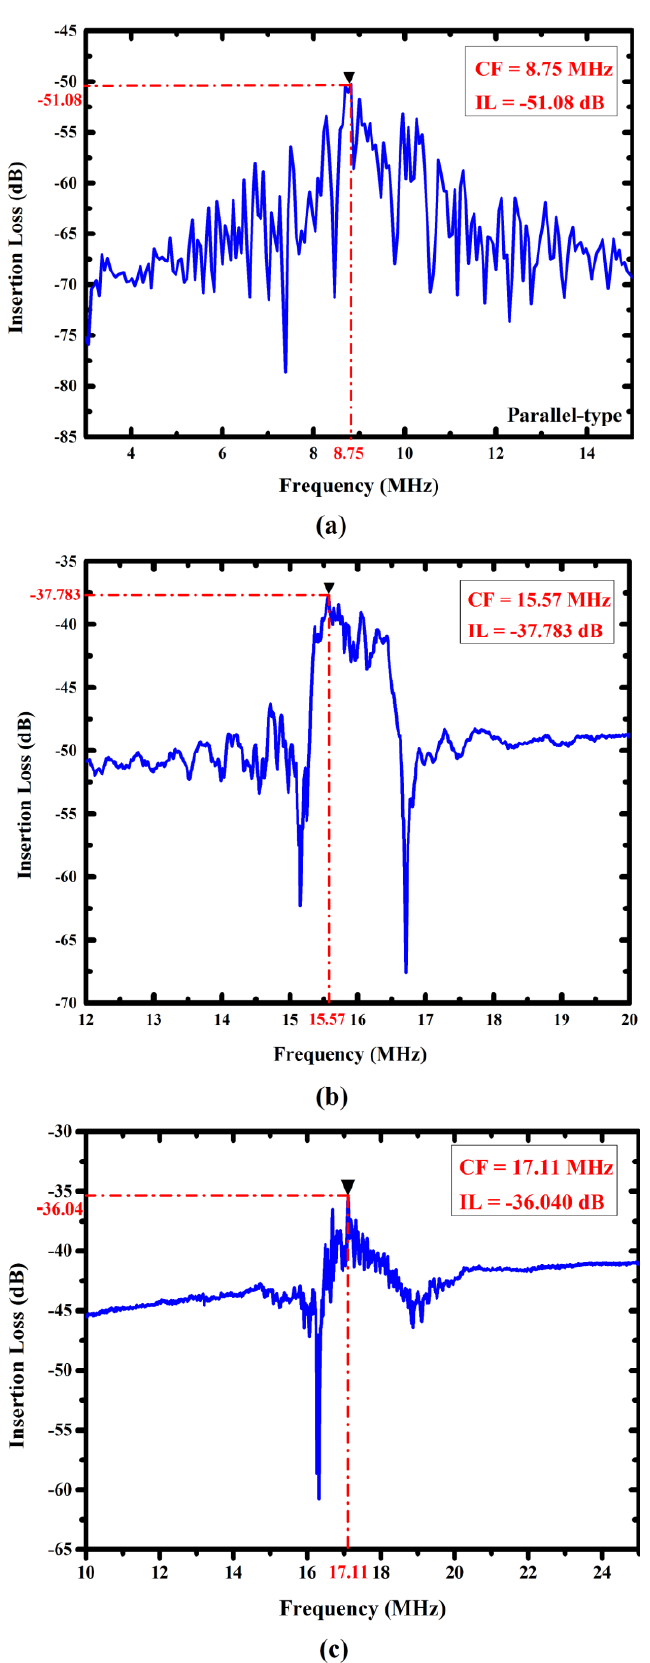
Figure 8. Frequency responses of the FPW device with ( a ) conventional parallel type; ( b ) fan-shaped type; and ( c ) circular type IDTs/RGS